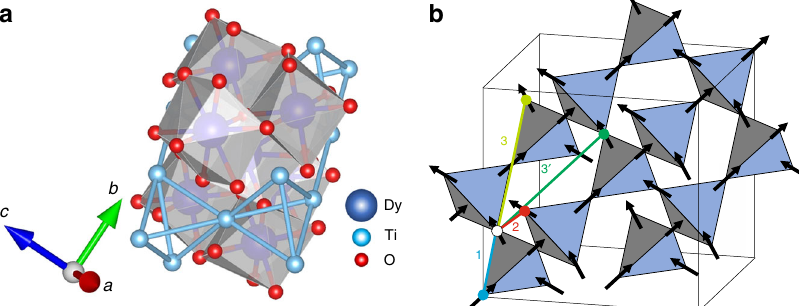
Fig. 1 Crystal structure and the effective magnetic model. a Atomic structure of Dy 2 Ti 2 O 7 comprised of tetrahedra of magnetic Dy ions (blue) and nonmagnetic octahedra of oxygen ions (red) surrounding Ti ions (cyan). b The magnetic moments located on Dy ions are constrained by crystal fi eld interactions to point in or out of the tetrahedra. They form a corner sharing pyrochlore lattice. The pathways of nearest neighbor (1), next-nearest-neighbor (2) and two inequivalent next-next-nearest neighbor (3 and 3 ′ ) interactions are shown as thick colored